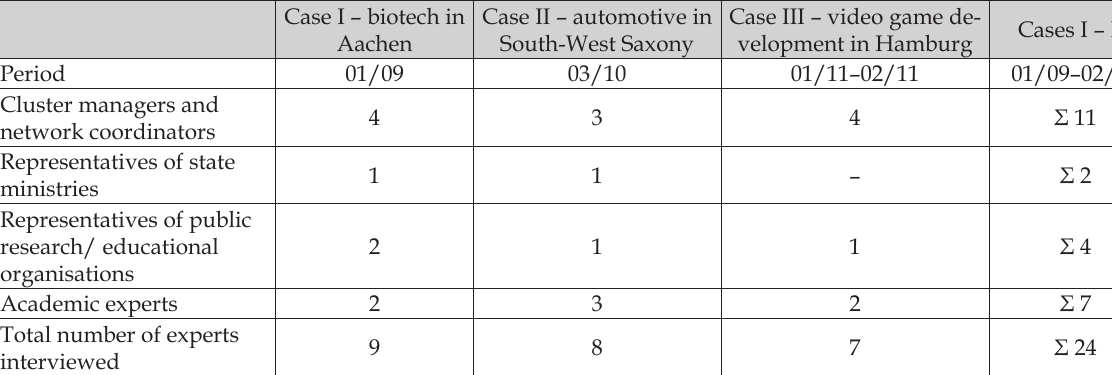
Table 3. Overview of expert